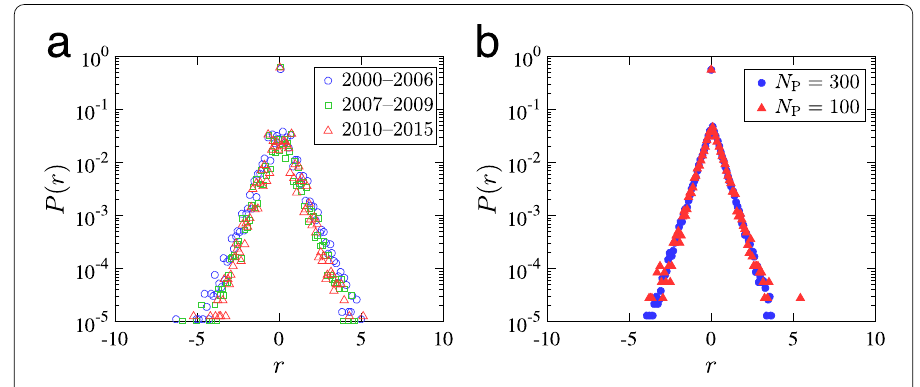
Figure 8 Distribution of the growth rates of edge weights r (aggregated over all bank pairs) for ( a ) the data and ( b ) the